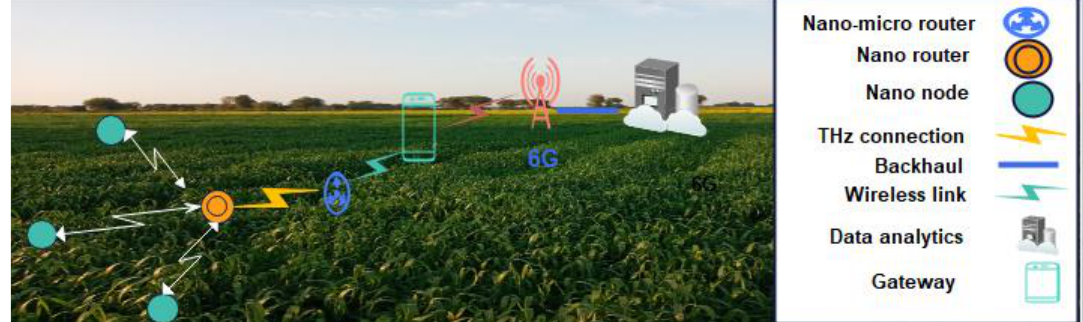
Figure 7. Envisioned smart production architecture using 6G.